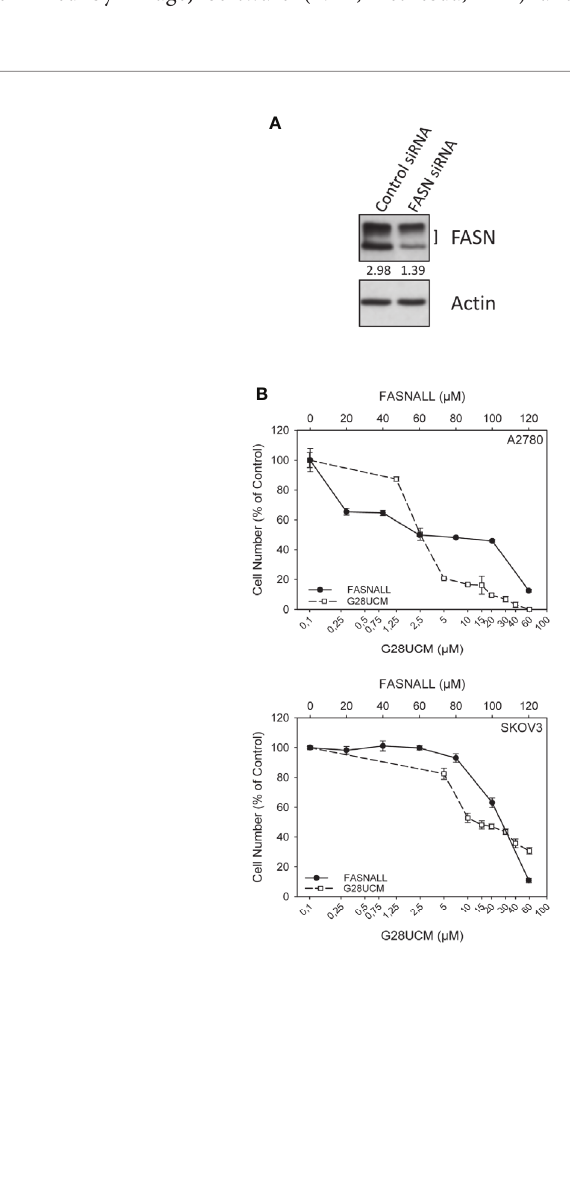
FIGURE 1 | Growth of OC cells is dependent on FASN. (A) Down-regulation of FASN protein expression by transfection of FASN siRNAs (30nM) was proven by Western blotting (left, one of three independent experiments) and was found to correlate with reduction of cell growth in A2780 cells (right). Results were obtained after 72 hours of incubation and are expressed in % of Control. Means ± SD, n = 3. One-tailed Student ’ s t-test at p < 0.01 (**) between cells transfected with non- targeting control siRNA (Control) or with FASN-targeting siRNA (FASN). (B) The FASN inhibitors G28UCM and Fasnall dose-dependently inhibit in vitro growth of A2780, OVCAR3 and SKOV3 OC cell lines after 72 hours of drug exposure. Note that concentrations of G28UCM are on a logarithmic, while Fasnall concentrations are on a linear scale. Formazan dye assay, means ± SD, n = 3. (C) Western blot analysis of dose- and time-dependent induction of apoptosis by G28UCM in A2780 OC cells as demonstrated by expression of PARP1 cleavage products ( ◄ ). Actin was used as loading control. The band intensities were determined using ImageJ software and the ratios between FASN (both bands in the left panel in (A) marked with]) or PARP1 cleavage products ( ◄ in C ) and actin were given under the FASN (A) or PARP1 (C) autoradiographs. One of two independent determinations is